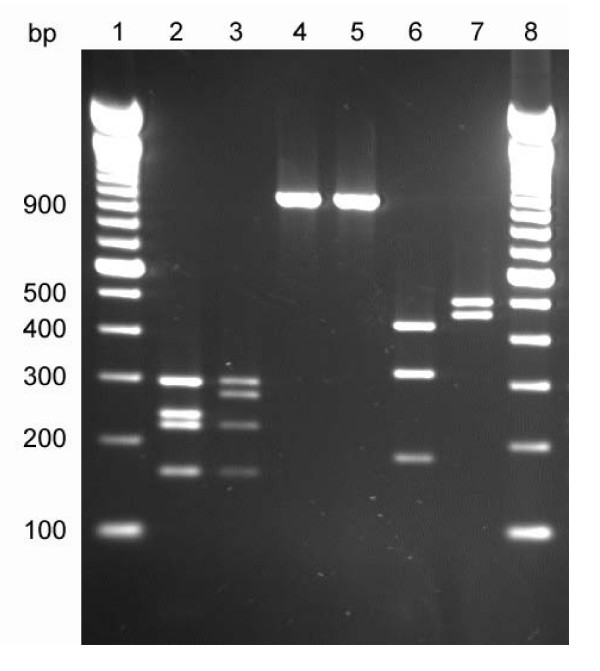
Electrophoretic separation of restriction enzyme digested fliC PCR products (primers fliC-1 and fliC-2) of E. coli strains U9-41 and P12b on 2% agarose: Lanes: 1+8= molecular weight standard; 2 = U9-41 (HpaII); 3 = P12b (HpaII); 4 = U9-41 (undigested); 5 = P12b (undigested); 6 = U9-41 (MboI); 7 = P12b (MboI). Sizes of restriction fragments are listed in Table 2.